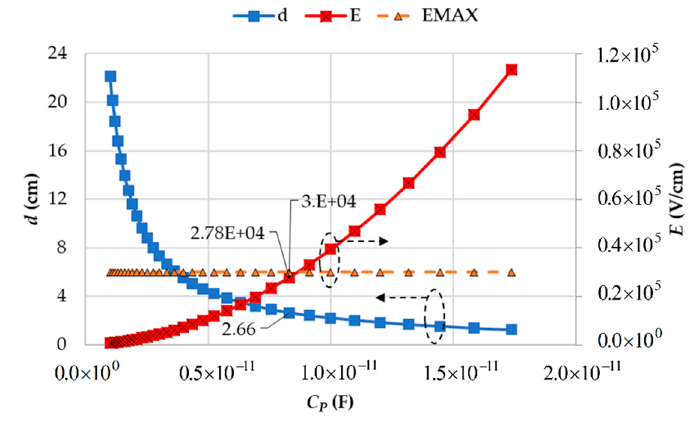
Figure 20. Gap and EF levels for various parasitic-capacitance values.